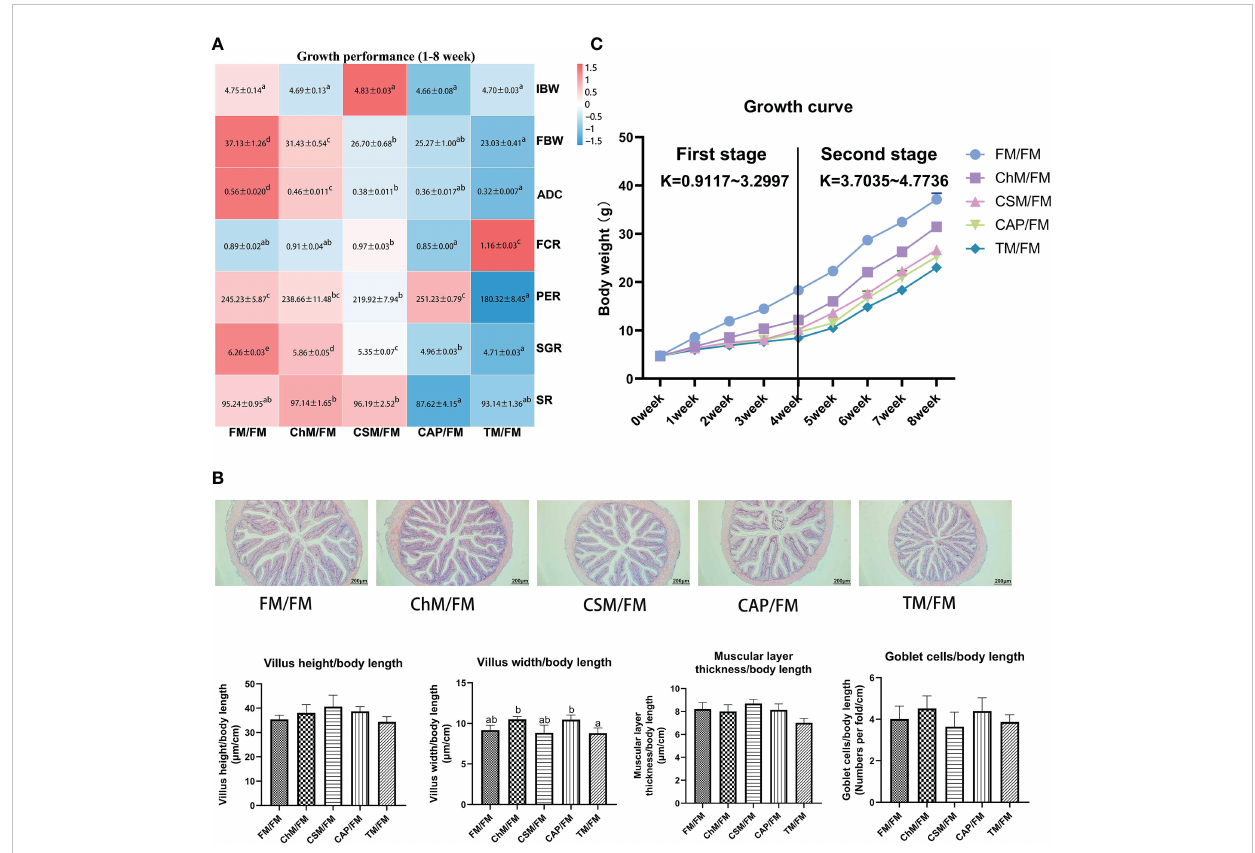
FIGURE 2 The growth performance and intestinal morphology of juvenile largemouth bass under an alternate feeding strategy. Growth performance heatmap (A) ;The distal intestines of FM/FM, ChM/FM, CSM/FM, CAP/FM, and TM/FM protein diet under 100 x magni fi cation and the intestinal quantitative data. (B) ; Wight gain growth curve (C) . Data are also expressed as mean (S.E.M). Values on each column/heatmap with different superscripts typi fi ed statistical differences ( P<0.05